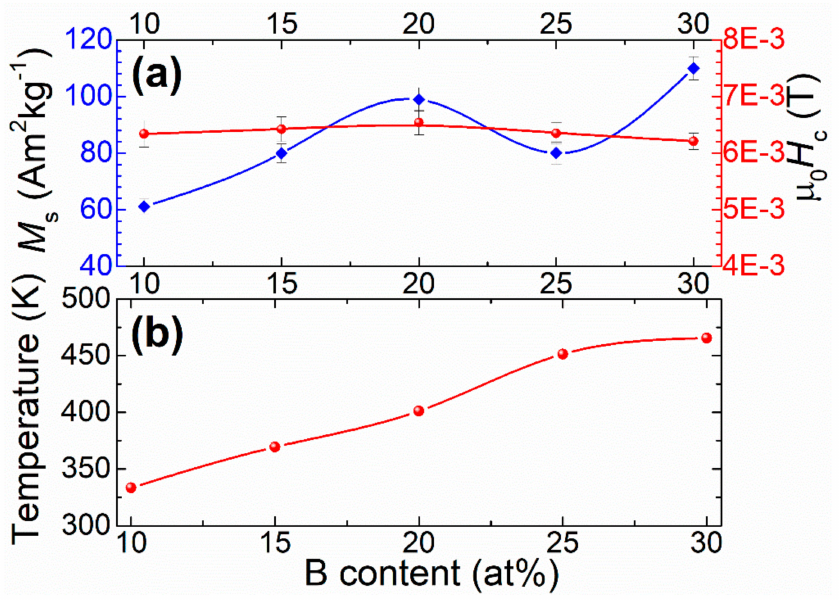
Figure 5. B-content dependence for Fe 91 − x Zr 5 Nb 4 B x (x = 10, 15, 20, 25, 30 at%) melt-spun ribbons: ( a ) M s and H c ; and ( b ) the change of the Curie temperature. The lines are guide for the